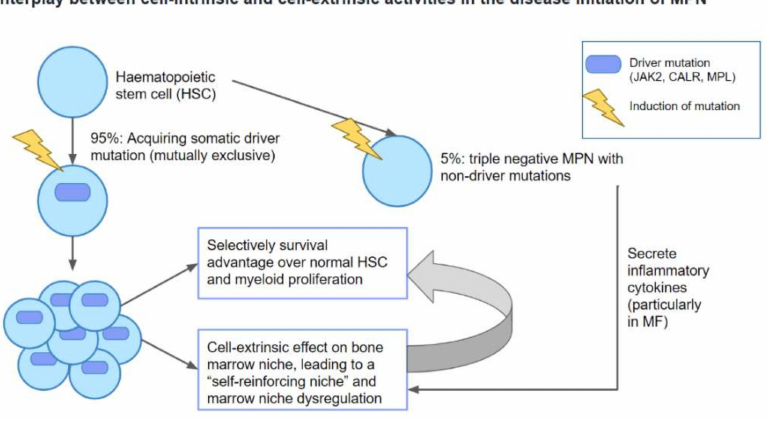
Figure 1. Interplay between cell-intrinsic and cell-extrinsic activities in the disease initiation of MPN. MPN: myeloproliferative neoplasm; MF: myelofibrosis.